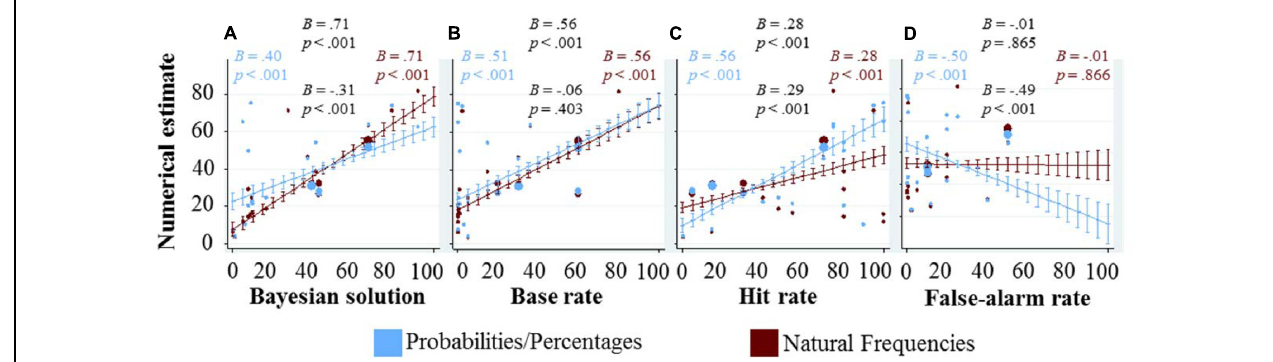
FIGURE 2 | Graphical exploration of how the quantitative variables (displayed at the x-axes) affect the numerical estimates (displayed at the y-axis). Each blue dot represents the average response in the probability/percentage version of a task, each red dot the average response in the natural frequency version, and the size of each dot indicates the number of responses on which these averages are based (see also the rightmost column of Table 1 ). The marginal effects and their confidence intervals are based on regression analysis. In (A) showing the Bayesian solution on the x -axis, the regression included only representation format and the Bayesian solution as main effects, as well as their interaction. It does not include the three quantitative variables as control variables, as the Bayesian solution already combines them (according to Bayes’ rule). The other three panels (B–D) display the three quantitative variables, base rate, hit rate, and false-alarm rate on the x -axis. Each of the marginal effects and confidence intervals was computed with representation format and all three quantitative variables as main effects as well as interaction effects between representation format